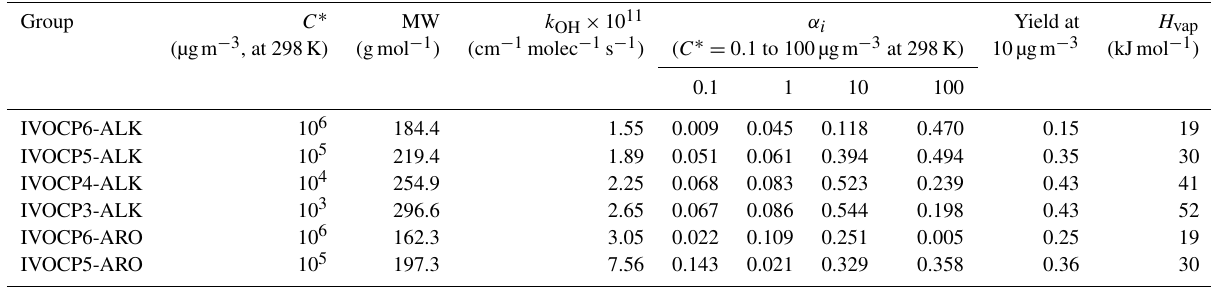
Table 2. Properties and stoichiometric mass-based product yields for six-group IVOC–SOA parameterization. Group C